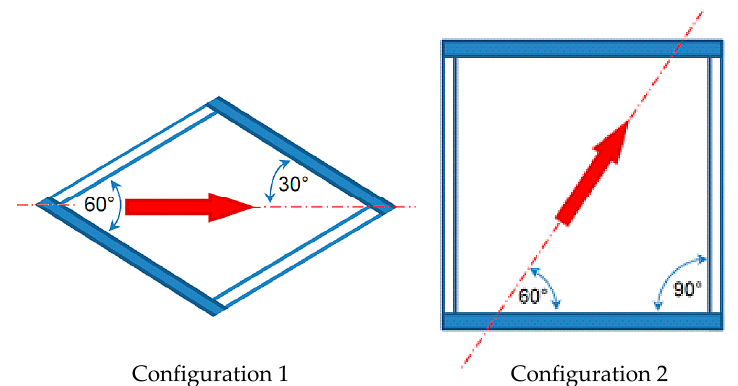
Figure 5. Sketch of the configurations for which experimental and computational distributions of the normalized heat transfer coefficient are compared. The intrinsic angle θ between the filaments and the flow attack angle α are reported.